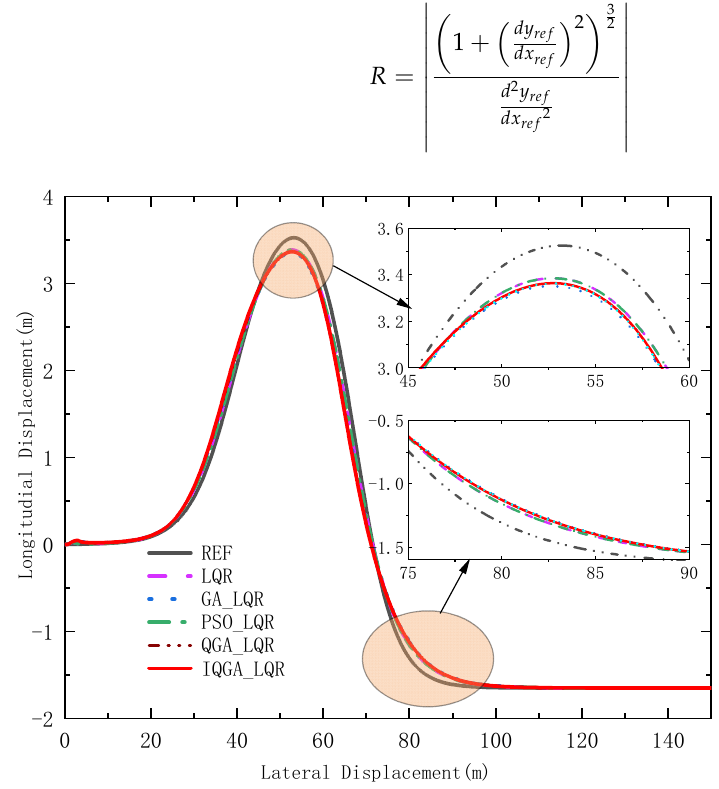
Figure 11. Reference trajectory and actual trajectory.